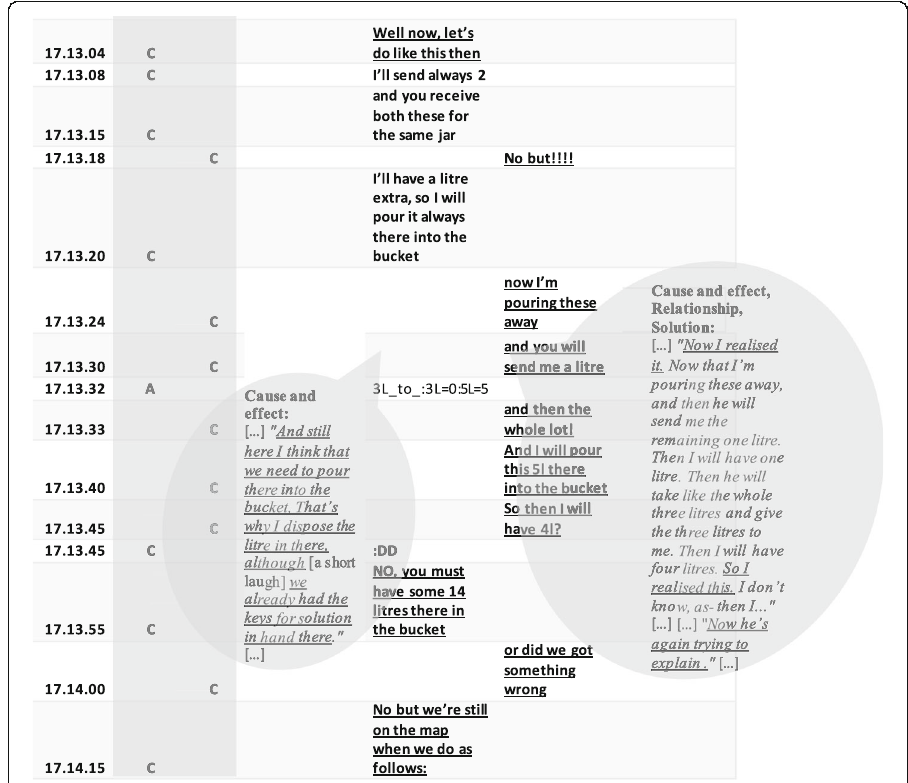
Fig. 9 Unbalanced CPS process in terms of the dynamics of interaction (pair 29, Olive Oil). The excerpt includes a time-stamped, condensed activity pattern (A = action, C = chat). The dialogue is extracted from the activity log, and the speech bubbles contain excerpts from the coded CRR data. (Translated from